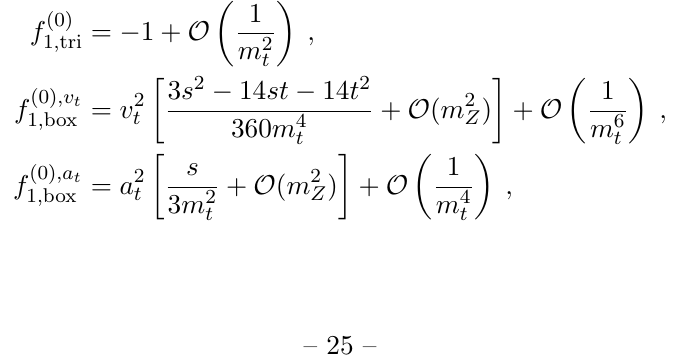
F (1) ; : : : ; F (1) as a function of p s , for (cid:18) = (cid:25)= 11 18 e e